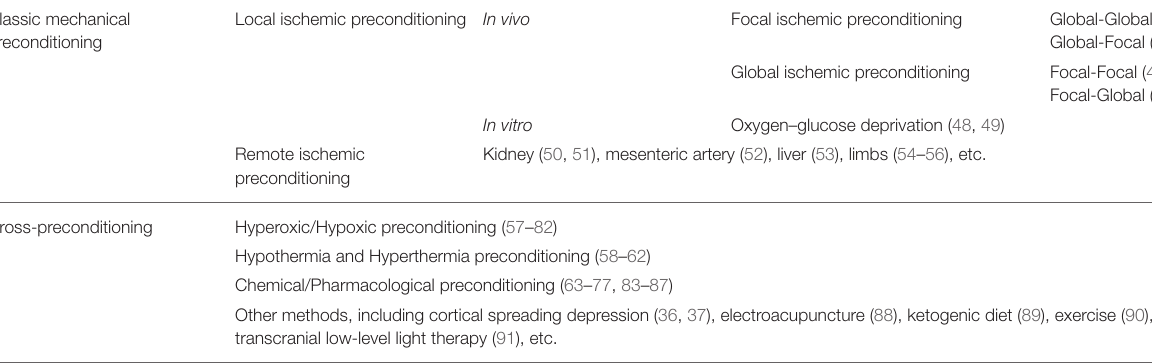
TABLE 1 | Representative reported methods of cerebral ischemic preconditioning. Classic mechanical